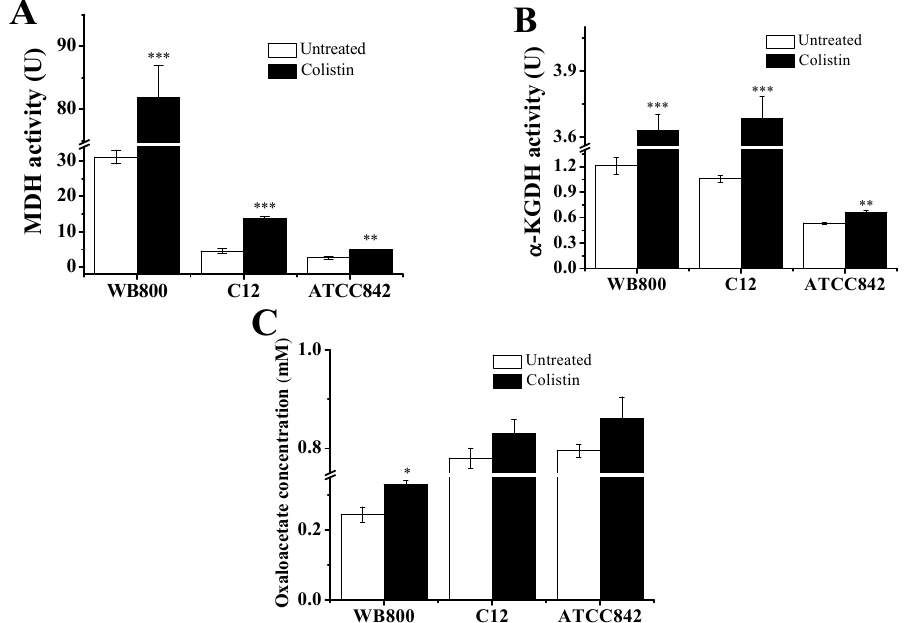
Figure 4. Colistin-induced changes in activity of enzymes and concentration of metabolite in TCA cycle. ( A ) Activity of malate dehydrogenase (MDH); ( B ) activity of α -ketoglutaric dehydrogenase ( α -KGDH); ( C ) oxaloacetate concentration. Data were expressed as mean ± standard deviation. When the probability ( p -value) was less than 0.05, 0.01 and 0.001, the values were considered significantly (*), very significantly (**) and extremely significantly (***) different, respectively. WB800: Bacillus subtilis WB800; C12: Paenibacillus polymyxa C12; ATCC842: Paenibacillus polymyxa ATCC842.